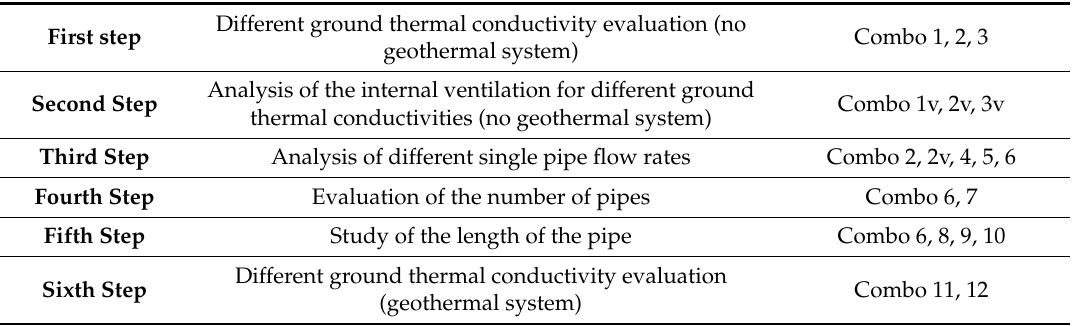
Table 6. Development of the methodology.